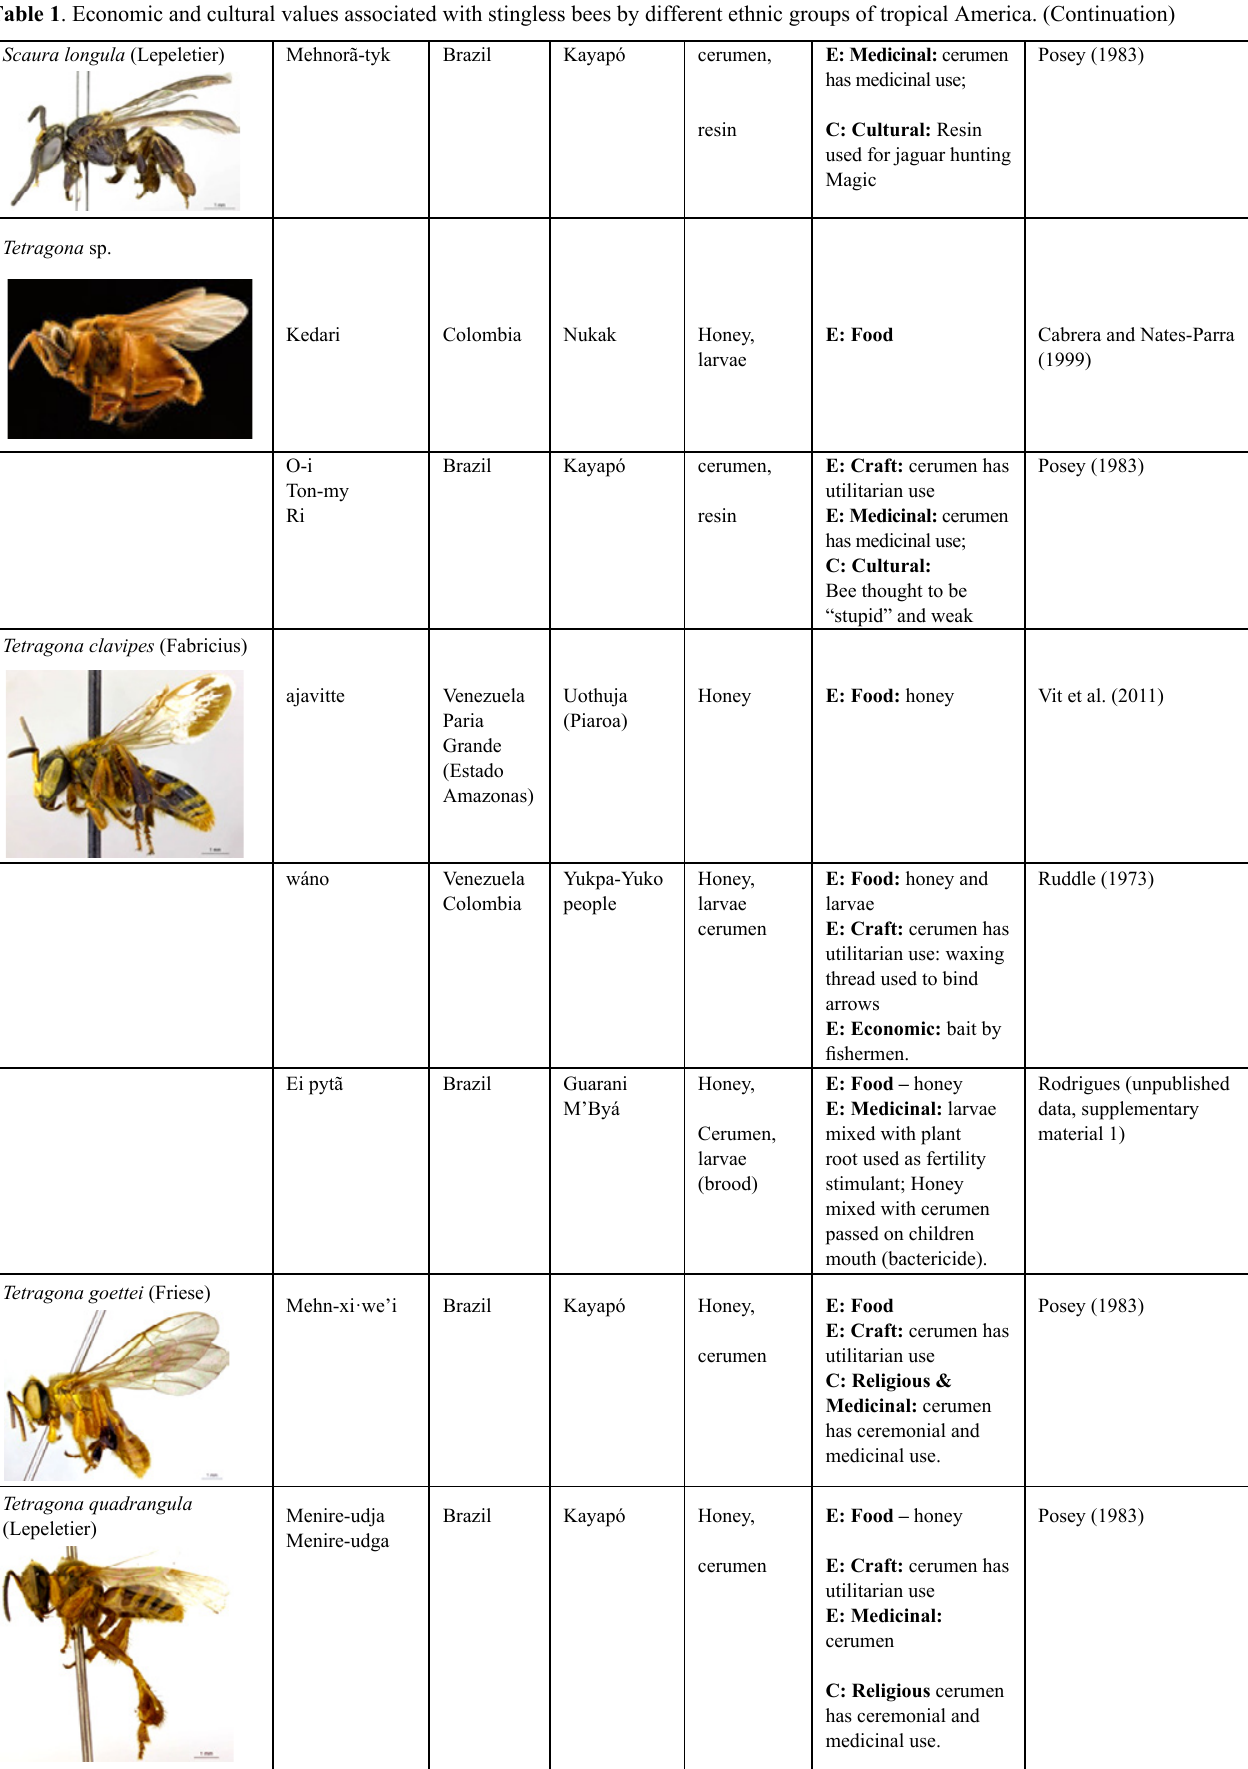
JJG Quezada-Euán, G Nates-Parra, MM Maués, VL Imperatriz-Fonseca, DW Roubik – Economic and Cultural Values of Stingless Bees 554 Table 1 . Economic and cultural values associated with stingless bees by different ethnic groups of tropical America. Scaura longula (Lepeletier) Mehnorã-tyk Brazil Kayapó cerumen, Tetragona sp.